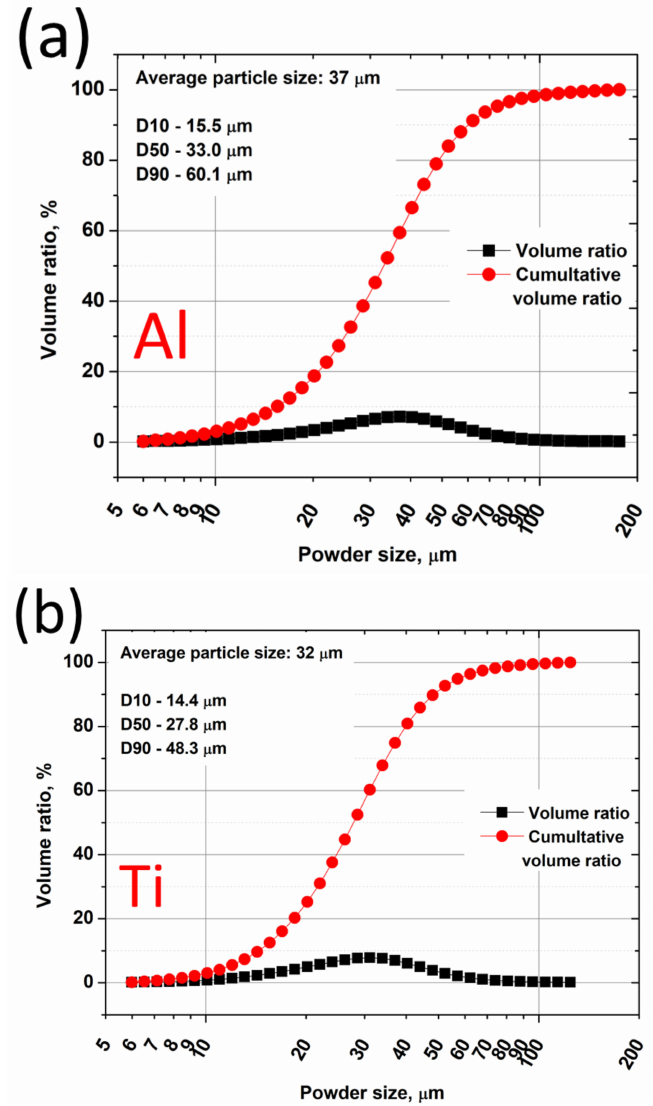
Figure 2. Al ( a ) and Ti ( b ) feedstock powder particle size